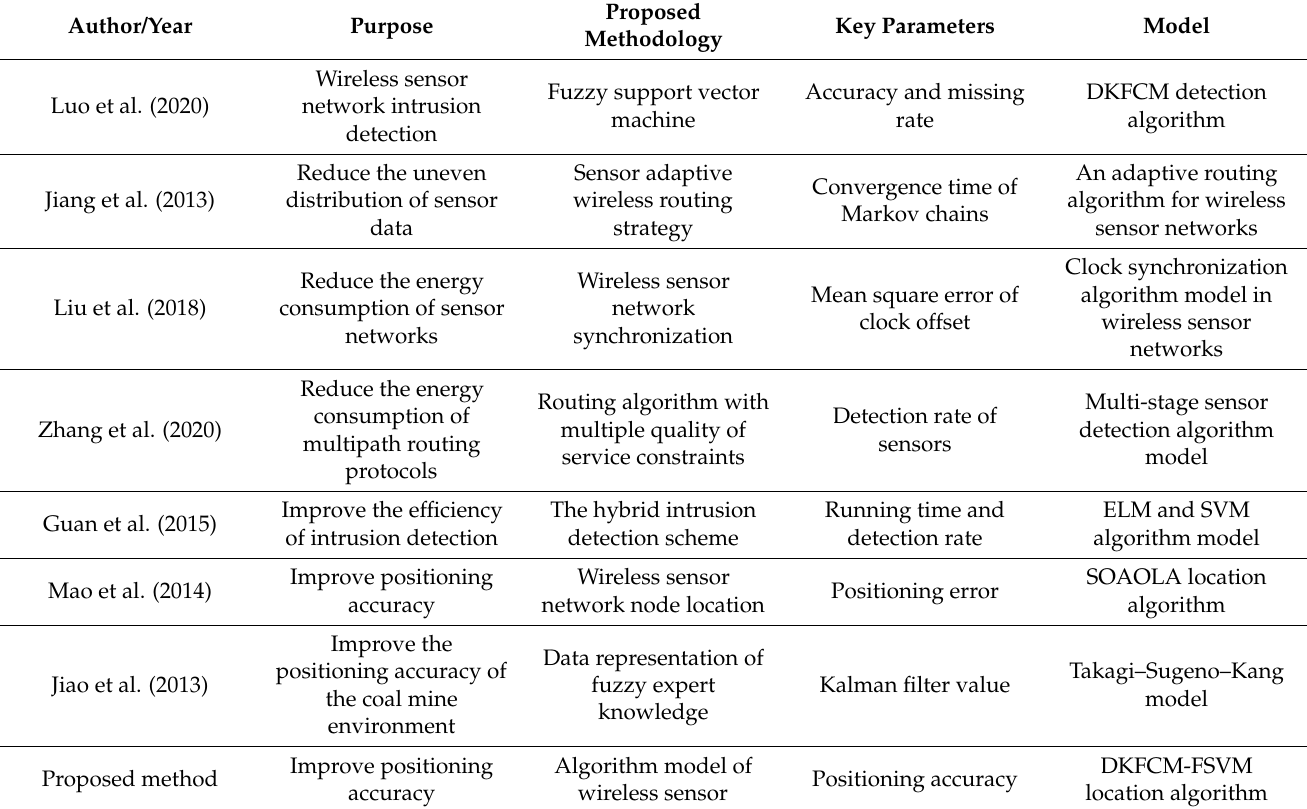
Table 1. Comparison of